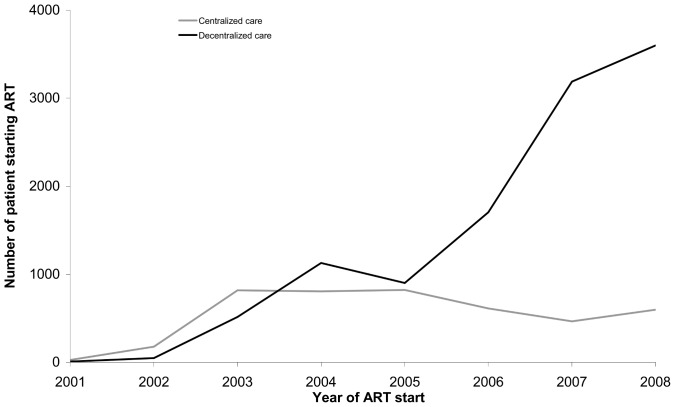
Trends in cART enrollment in centralized and decentralized sites, Chiradzulu, Malawi, 2001–2008.